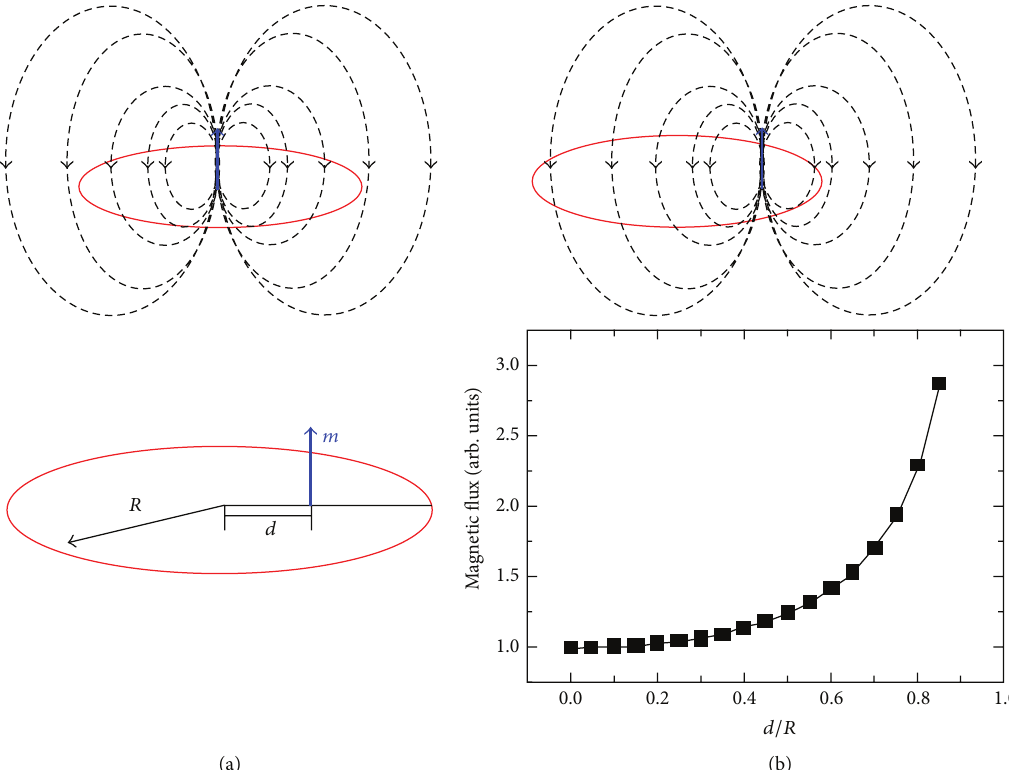
Figure 12: The effect of sample and coils positions on magnetic flux distribution. In case (a), the positions of sample and coil are determined by arrow and circle, respectively. Moreover, the sample distance from center point is defined by “ 𝑑 ” symbol. In (b) case, it is clear that the imbalance position of sample and coil led to creating considerable errors in flux amounts